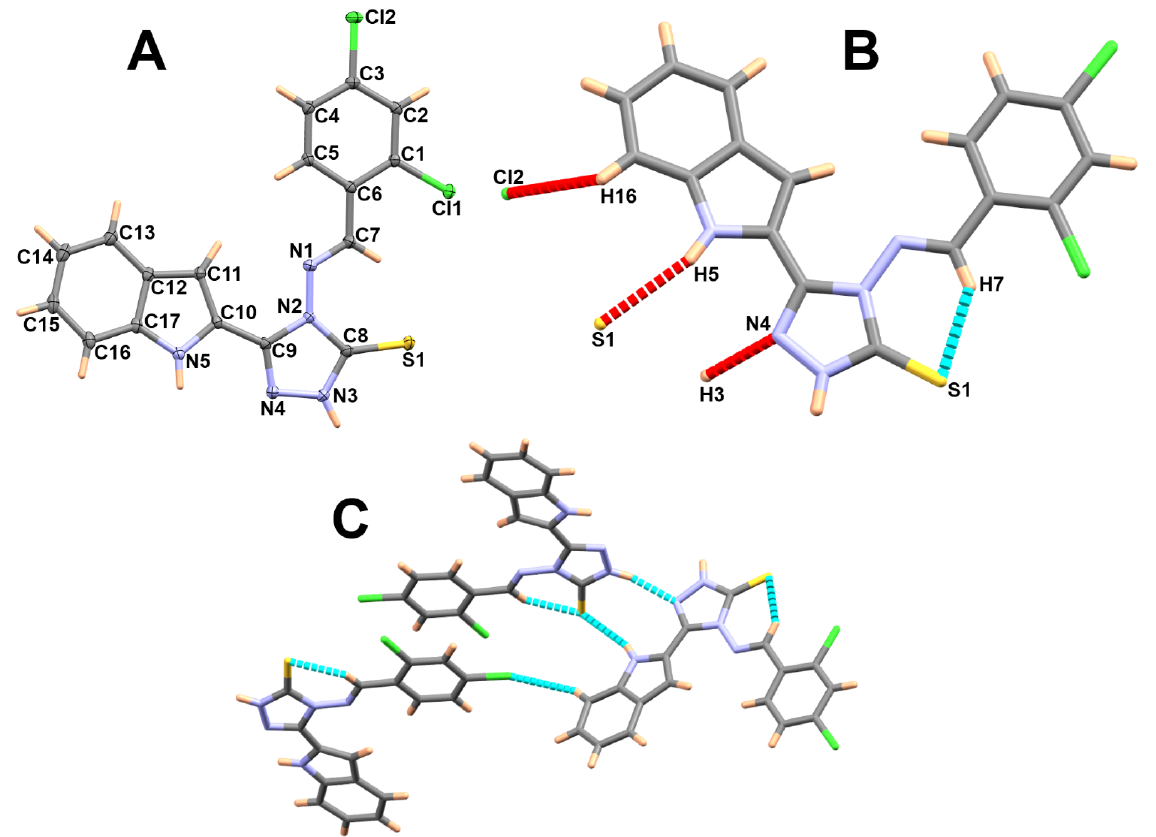
Figure 2. Structure of the asymmetric unit with atomic numbering and thermal ellipsoids drawn at 30% probability ( A ), most important hydrogen bond contacts ( B ) and hydrogen bonding interactions ( C ) in 4 .